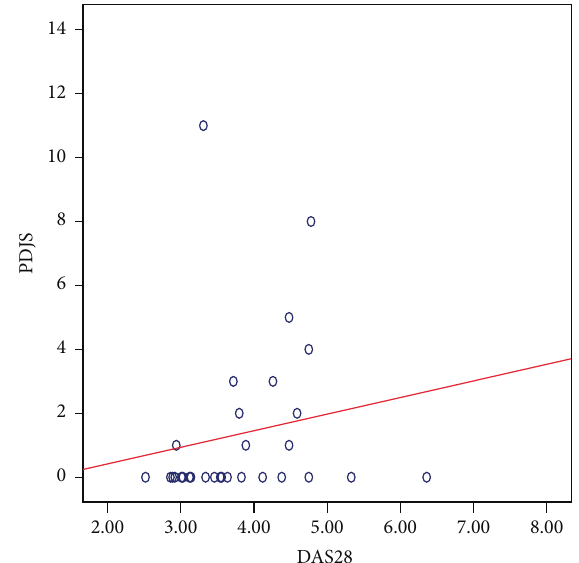
Figure 5: Relation between GSJS (taken from 28 MCP, PIP, and DIP joints) and DAS28 score in 30 patients with PsA. Spearman’s 𝜌 : 0.499; 𝑃 : 0.005 suggesting a significant correlation.